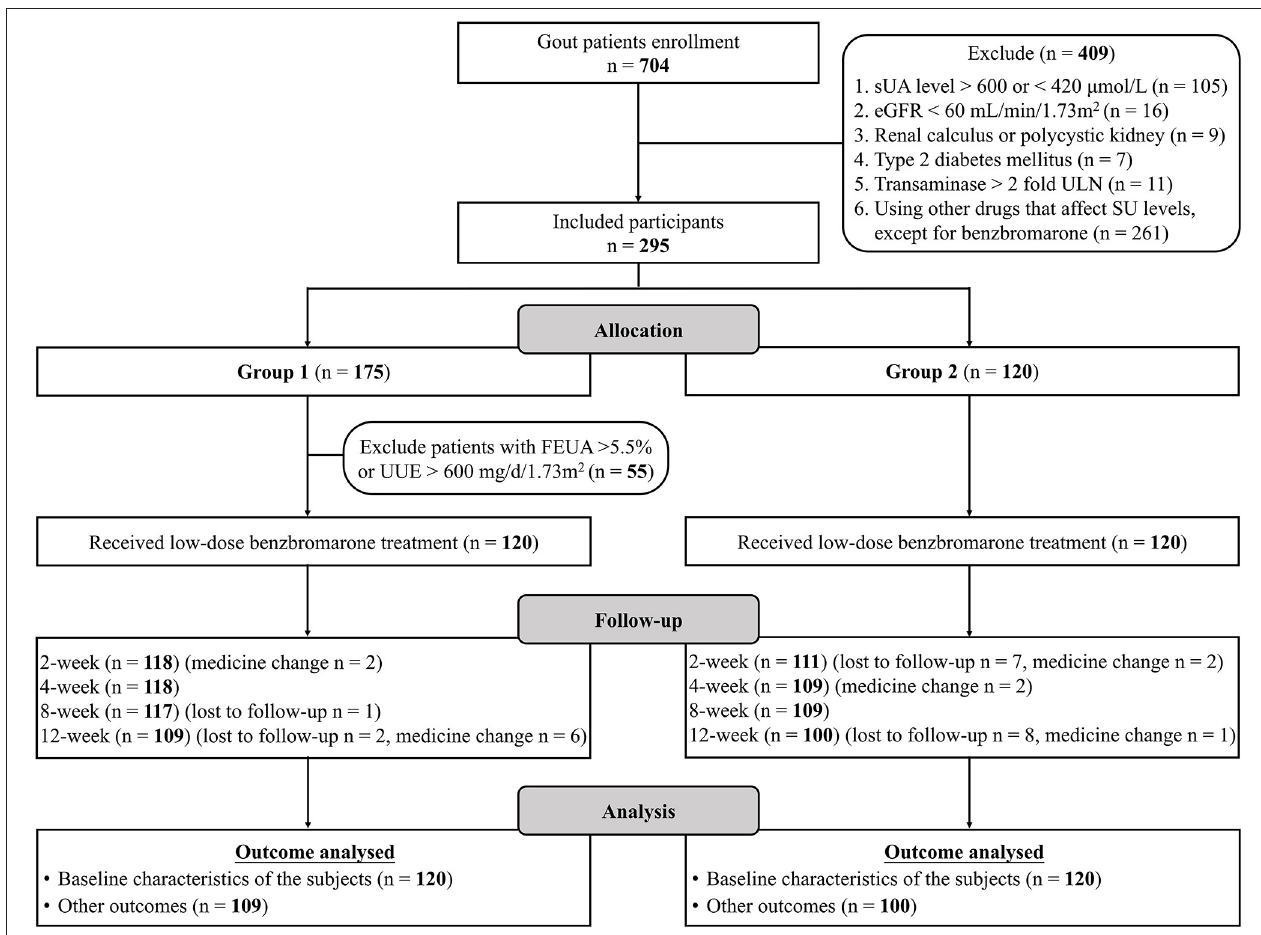
FIGURE 1 | Study flow chart. SU, Serum urate; eGFR, estimated glomerular filtration rate; SU, serum urate; FEUA, fractional excretion of urate; UUE, urinary urate